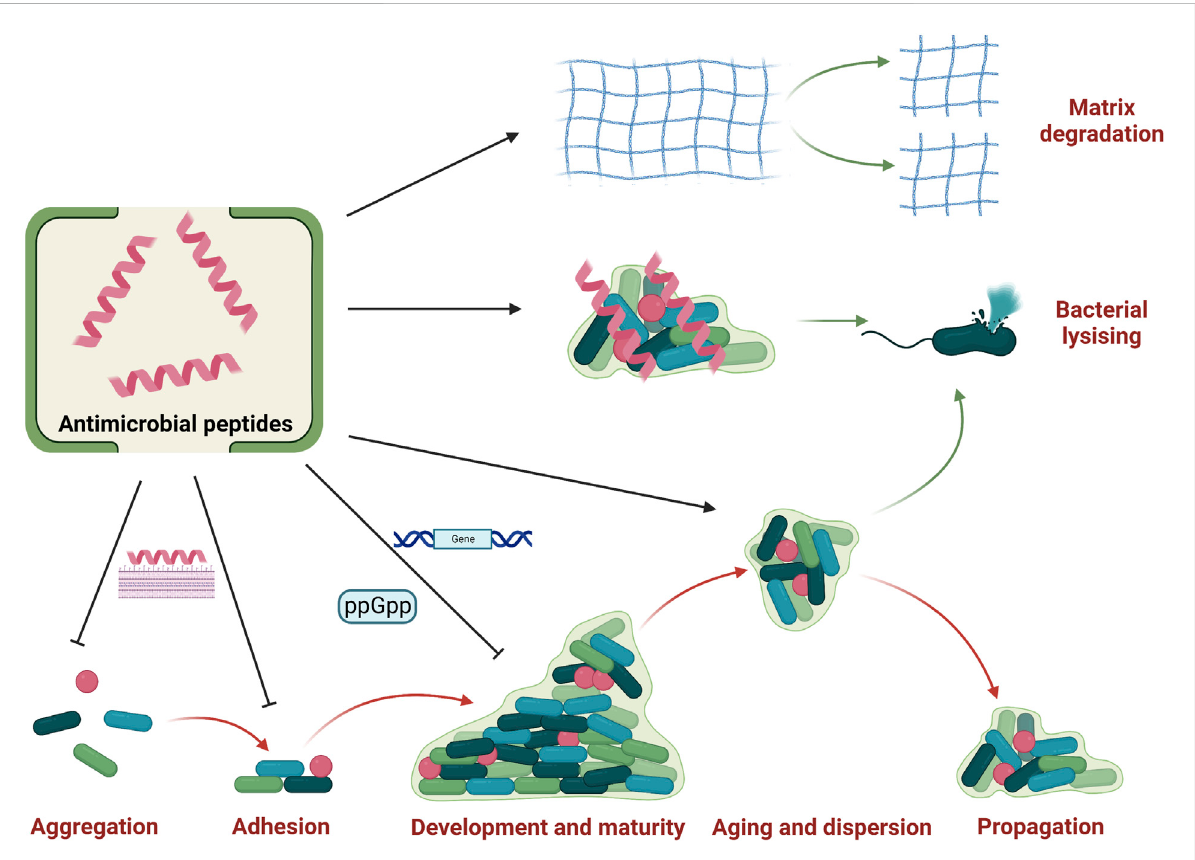
FIGURE 5 Anti-bio fi lm properties of antimicrobial peptides. Antimicrobial peptides could in fl uence the bio fi lm cycle by inhibiting aggregation and adhesion as well as restraining the development and maturity. They also promote bio fi lm aging and dispersion, thus exposing bacteria to antimicrobial peptides to induce bacterial lysis. Besides, some antimicrobial peptides could also promote the matrix degradation of established bio fi lm. And there are also some antimicrobial peptides could penetrated established bio fi lm and interact with bacteria to exert bactericidal activity. Created with